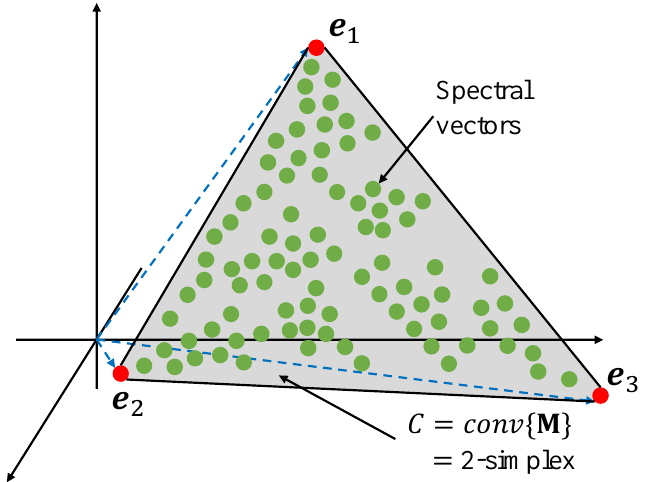
Figure 3. Geometrical illustration for the simplex set C for p = 3 endmembers. Red circles (vertices of the simplex) correspond to the endmembers. Green circles represent the spectral